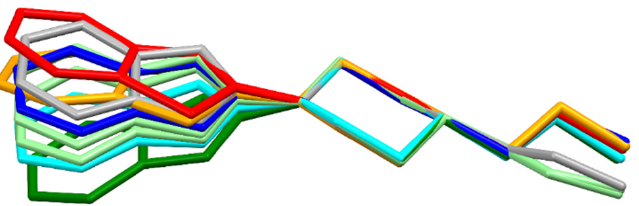
Figure 20. Overlay of molecules for all determined structures; 1 —blue; 2 —red; 3 —cyan; 4 —orange; 5 —green; 6 —light green; 7 —grey.